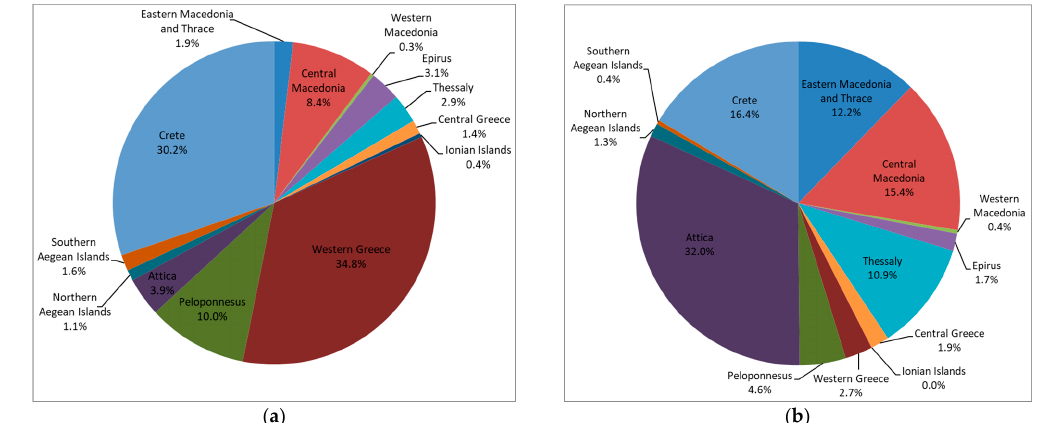
Figure 1. Distribution of lands covered by greenhouse ( a ) vegetables and ( b ) flower/ornamental plants in the administrative regions of Greece (data processed from HELSTAT [11]).